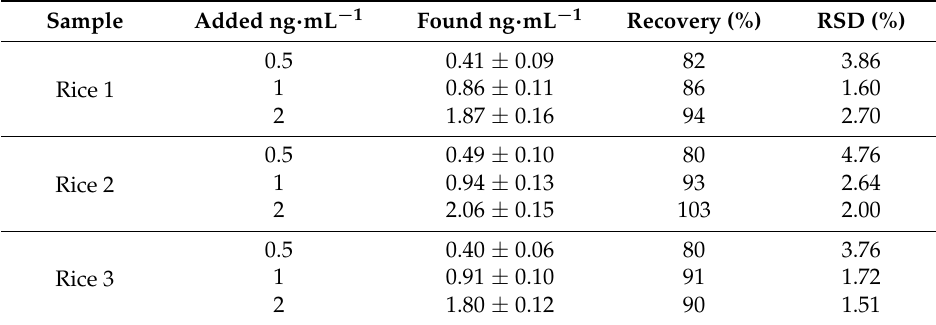
Table 2. The analysis results of Cd(II) ions in three spiked rice samples.